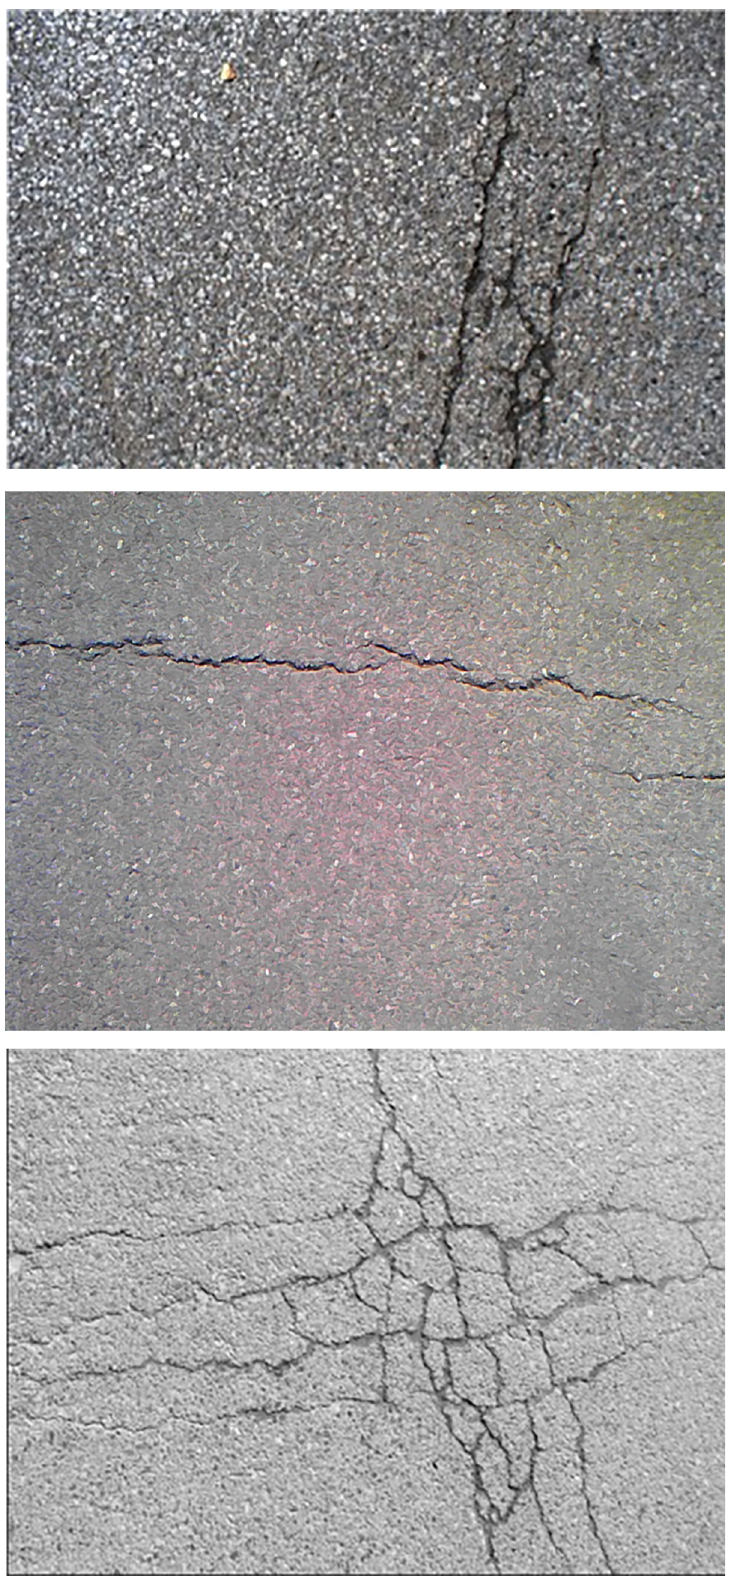
Fig 5. Typical collected pavement crack